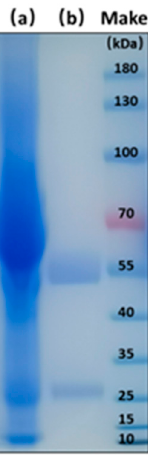
Figure 4. The electropherogram of BsMAb: ( a ) ascites; ( b ) purified BsMAb.